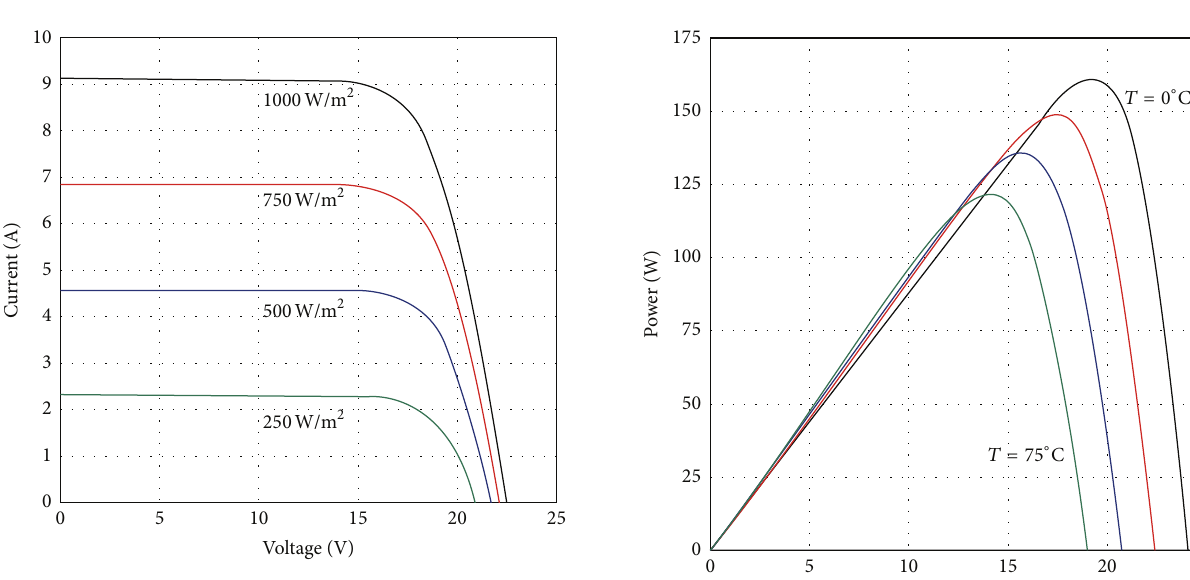
The cell efficiency and fill factor (FF) of BSM-150 pho- tovoltaic unit are calculated as 17.12% and 73.71, respectively (according to the data of Table 4).